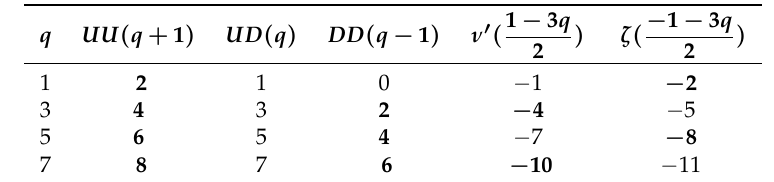
Table 2. List of possible integer charged techniparticles. Candidates for even charged constituents of dark atoms are marked bold [10].